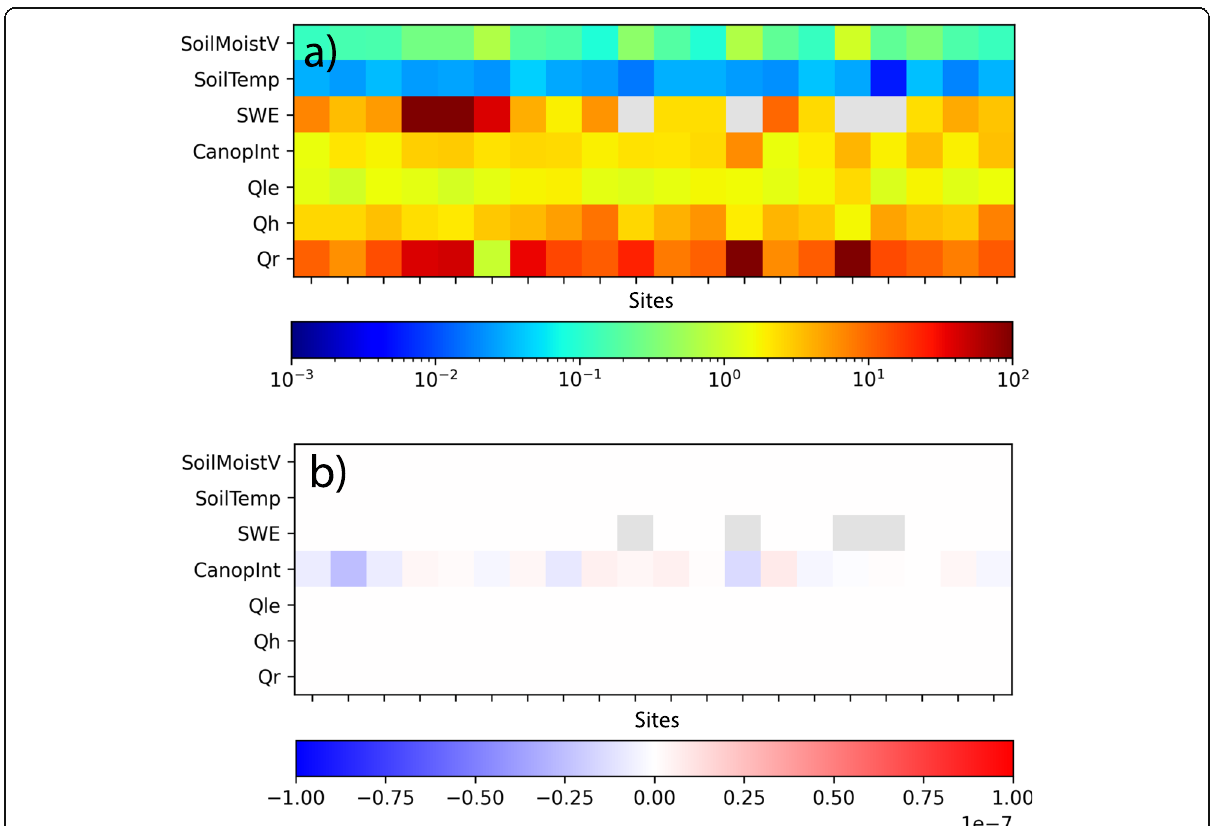
Fig. 2 a The normalized standard deviation of 7 variables simulated by the MIROC framework. The vertical axis shows soil moisture and temperature in the first layer, snow water equivalent, canopy water, latent heat flux, sensible heat flux, and runoff. The horizontal axis shows 20 Fluxnet sites. The standard deviation values are normalized by their mean. b As in a , but for the difference between MIROC framework and ILS normalized by